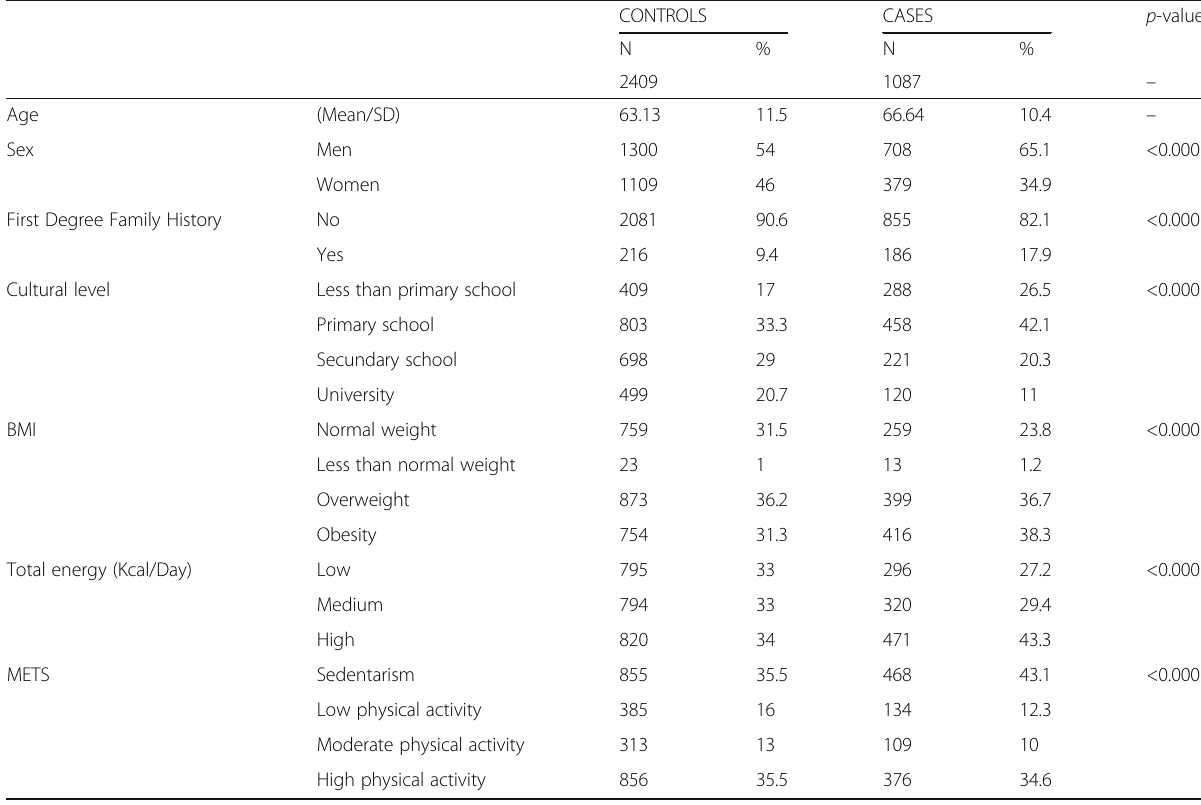
Table 1 Descriptive analysis results. Characteristics of cases and controls